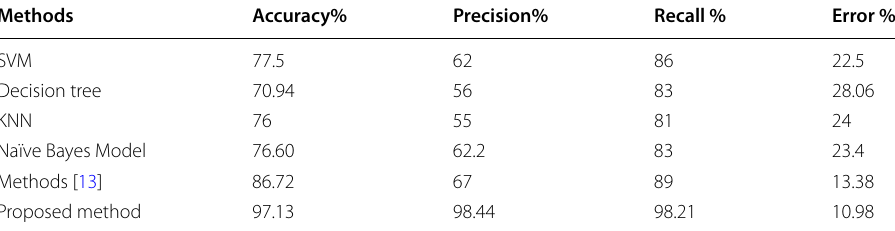
Table 4 The comparison of the proposed method based on LTSM deep neural network with that of [13] in terms of accuracy, precision, and